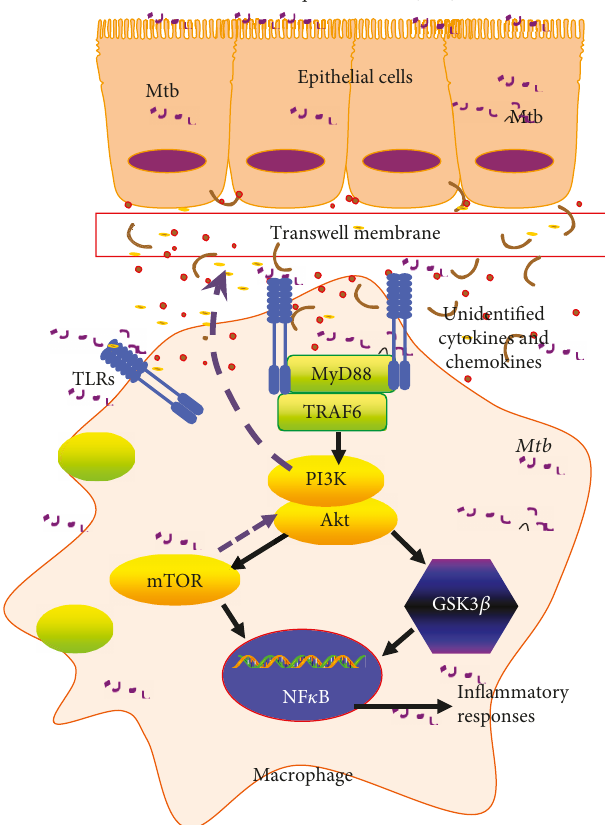
Figure 10: Scheme showing a possible mechanism of the alleviated TLR-mediated in fl ammatory responses of macrophage U937 cells to the mycobacterial infection by coinfected A549 epithelial cells. In a coinfected condition, the unde fi ned signaling from H37Rv mycobacteria- infected epithelial cells could reduce TLR-mediated in fl ammation of macrophages via the PI3K/Akt/mTOR signaling axis, but not the PI3K/Akt/GSK3 β pathway. Upon a coinfection of epithelial cells and macrophages to Mtb , the in fl ammatory responses in both host cell types were triggered in alveoli. In order to maintain the homeostasis of the alveolar microenvironment, the Mtb infection-induced epithelial cells subsequently alleviated the in fl ammation of the alveolar environment to secret soluble cytokines or mediators, which in turn inhibited the TLR-mediated in fl ammatory responses in macrophages to Mtb via the PI3K/Akt/mTOR